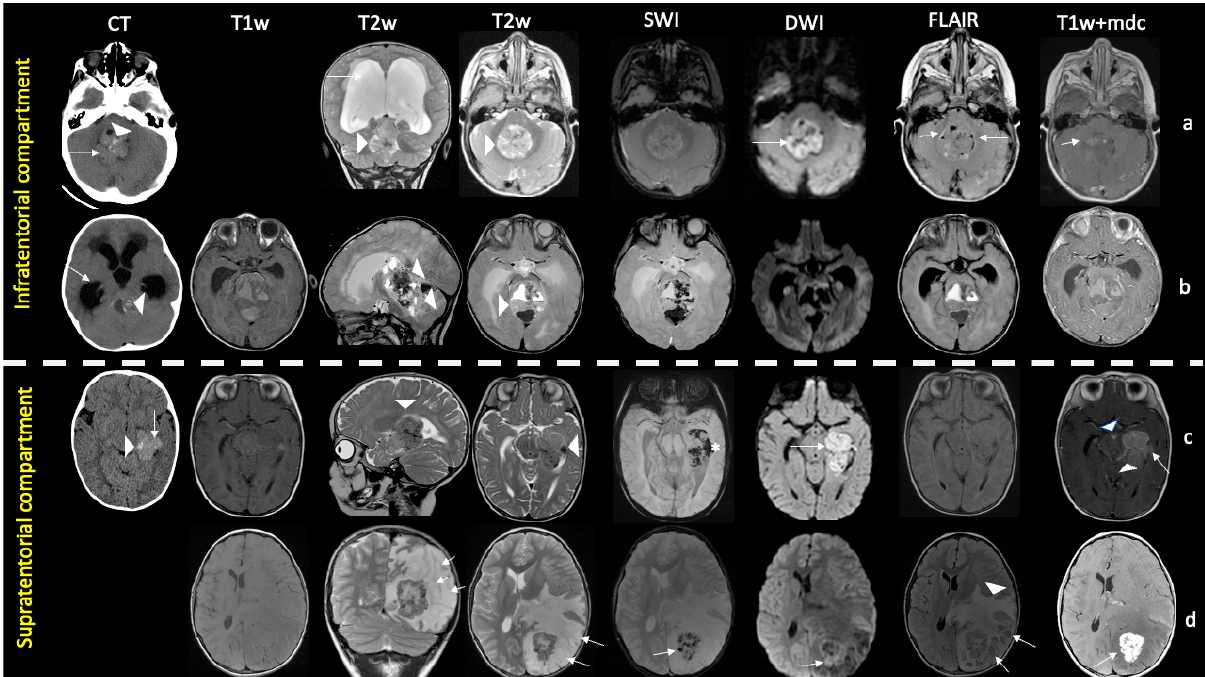
Figure 2. Imaging findings of pediatric ATRT in supra- and infratentorial compartments. Infratentorial ATRTs (rows ( a , b )). Row ( a ): One-year-old child with a prevalently solid mass centered in the IV ventricle, hyperintense to gray matter (arrowheads in T2w) with high density/restricted diffusion (arrows in CT, DWI) due to hypercellularity, minute eccentric cystic components (arrows in FLAIR), and mild enhancement (arrow in T1+mdc). Intratumoral foci of Ca++ (arrowhead in CT) are present, interstitial edema is absent. Hydrocephalus is shown (white arrow in T2). Row ( b ): a 4-month-old child with a bulky heterogeneous mix mass with epicenter in the posterior cranial fossa (IV ventricle and vermis) and supratentorial extension (arrowheads in T2w). The lesion contains small hyperdense foci of Ca++ (arrowhead in CT), hemorrhage both in solid and cystic component (hyperintense signal in T1w, hyperintense and hypointense signal in T2w, hypointense signal in SWI). Interstitial edema is absent. Hydrocephalus is detected (white arrow in CT). Supratentorial ATRTs (rows ( c , d )) . Row ( c ): a 7-month-old child with a solid and heterogeneous intracranial mass centered in the temporal lobe, near to lateral ventricle (arrowheads in T2w). It shows high density (arrow in CT) and restricted diffusivity (arrow in DWI) due to hypercellularity, containing foci of Ca++ (arrowhead in CT), areas of hemorrhage (*in SWI), and marked enhancement (arrow in T1+mdc). Note widespread subarachnoid metastatic disease filling the interpeduncular and perimesencephalic cisterns (arrowheads in T1+mdc). Row ( d ): a 10-year-old child with a mixed lesion in the parietal lobe consisting of a heterogeneous solid component due to hypercellular (arrow in DWI) and hemorrhagic areas (arrow in SWI) and multiple eccentric cysts (arrows in T2 and FLAIR); note marked enhancement (arrow in T1+mdc) of the solid component and abundant perimarginal edema (arrowhead in FLAIR).